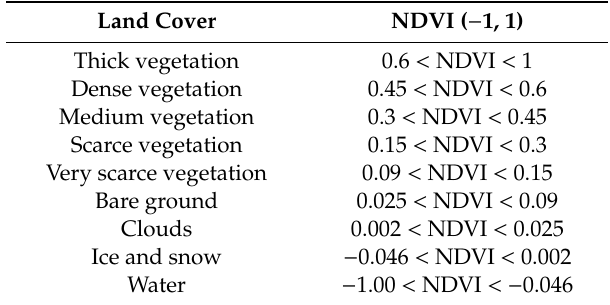
Table 3. Types of land cover with their relative NDVI values